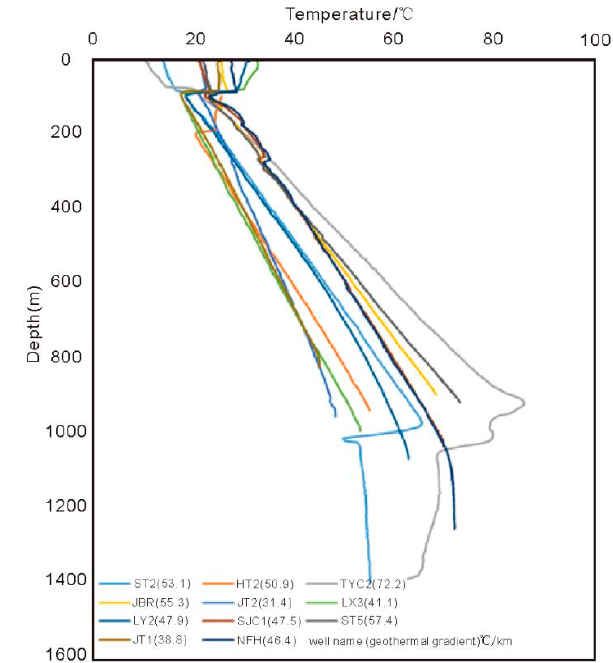
Figure 3. Temperature–depth graph of the geothermal wells in Xiong’an New Area (adapted from Li [14]). The temperature-measurement depths are as follows (m): ST2 (400–1000); HT2 (400–900); TYC2 (300–800); JBR (400–800); JT2 (300–800); LX3 (300–800); LY2 (300–800); SJC1 (400–800); ST5 (300–800); and JT1 (300–800). The measurement depths exhibit steady-state conduction.